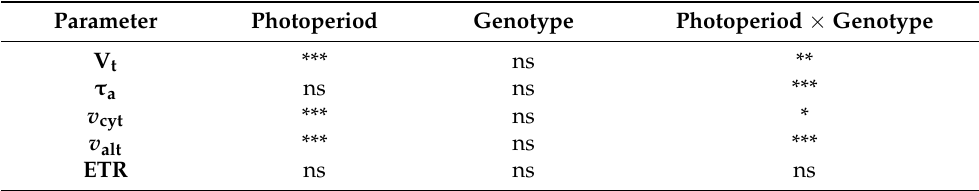
Table 1. Significance of sources of variation after two-way analysis of variance for each physiological parameter. The sources of variance were SD or LD conditions (photoperiod), plant genotype, and their interactions (photoperiod × genotype). V t , total respiration; τ a , electron partitioning to the AOX pathway; v cyt , COX pathway activity; v alt , AOX pathway activity; ETR, chloroplast